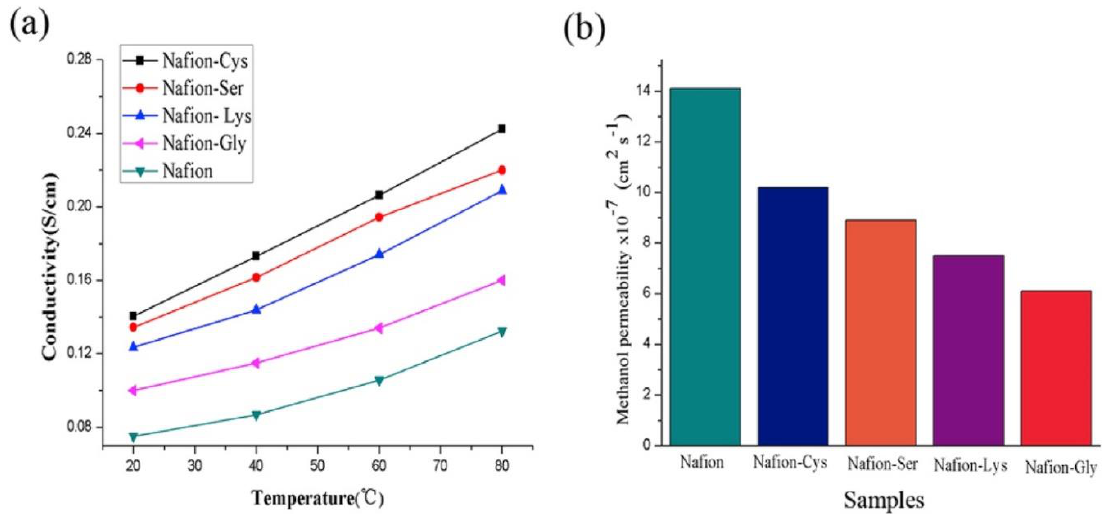
Figure 8. ( a ) Conductivity and ( b ) permeability (methanol) results of various nanofiber composites [194].